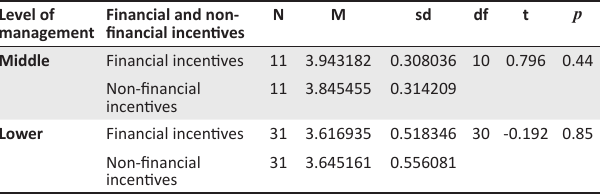
TABLE 1: Testing the difference between the importance of financial and non- financial